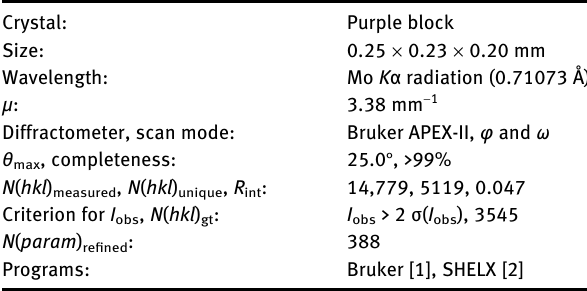
Table  : Data collection and